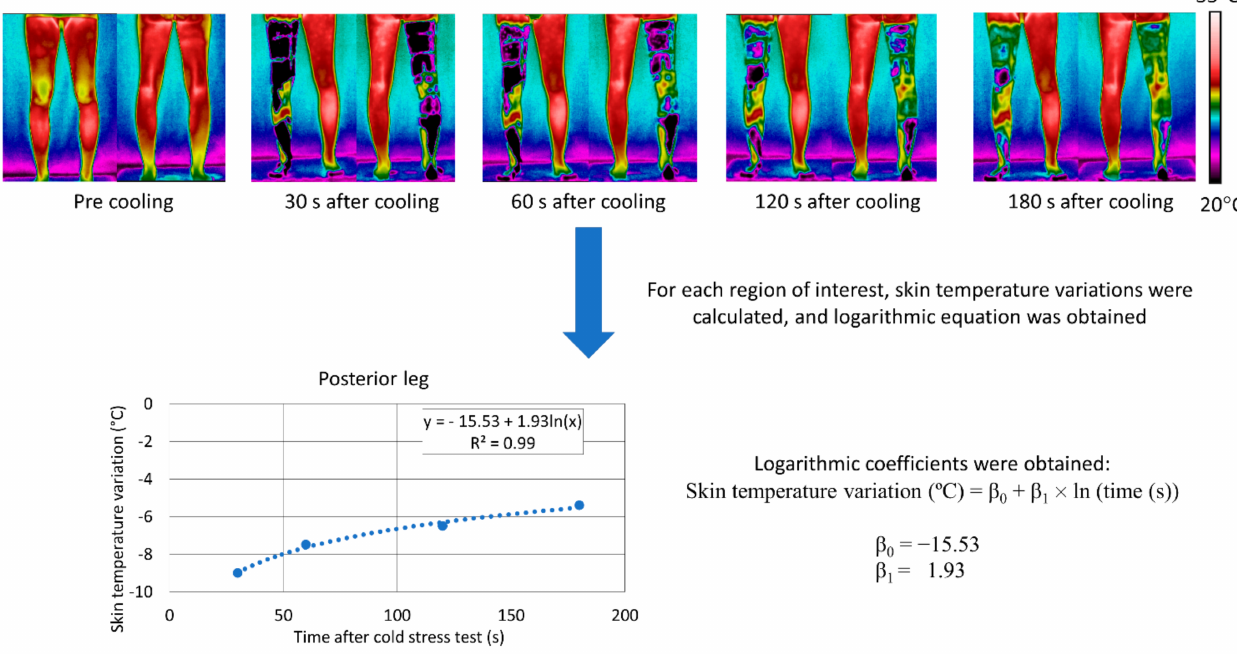
Figure 2. Schematic representation of the process to obtain the logarithmic coefficients to assess cold stress